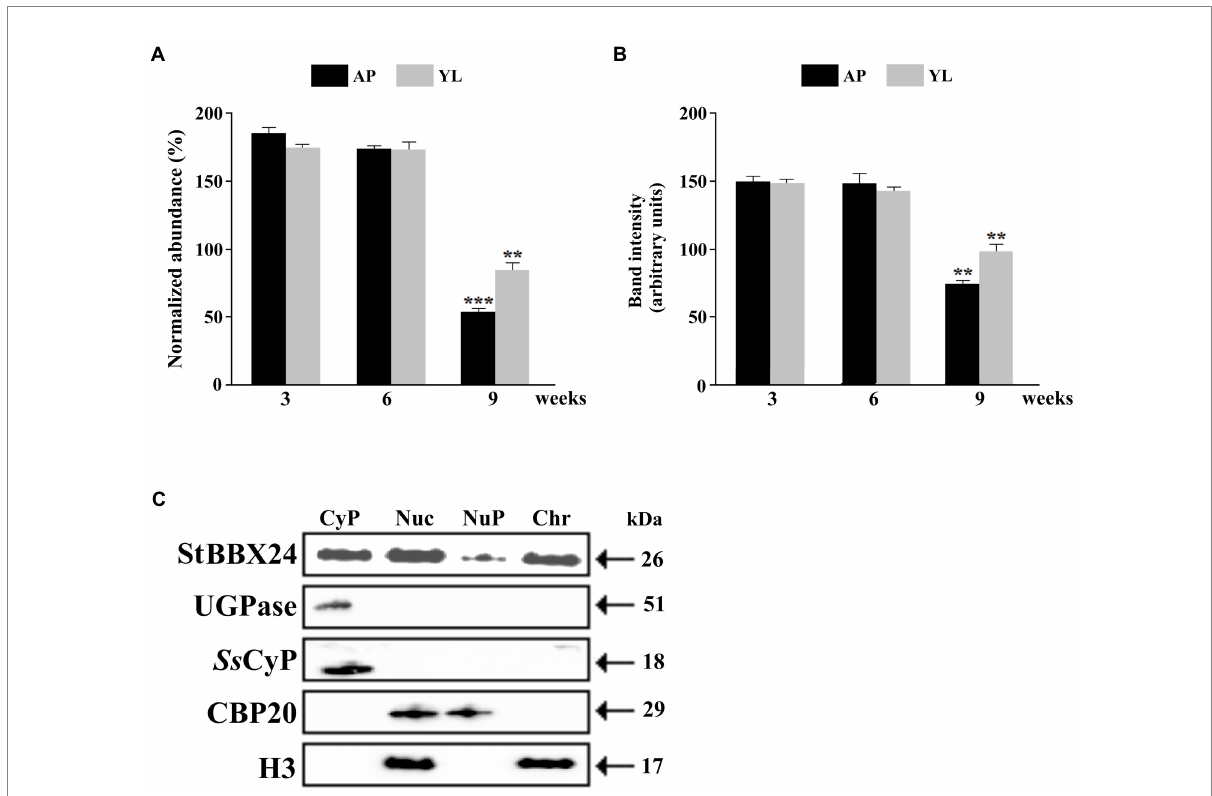
FIGURE 1 Expression of StBBX24 in young organs of S. tuberosum plants and nuclear localization of StBBX24. StBBX24 transcript (A) and protein (B) abundance in apical shoot parts and young leaves of phytotron-grown S. tuberosum plants. (A) Quantitative RT-PCR was performed as described in Materials and methods. (B) Western analysis of StBBX24 abundance was performed using sera raised against StBBX24 as described in Materials and methods. As a loading control of the total protein for cytosolic fraction, antibodies raised against cytosolic marker UGPase protein were used. AP – apical shoot part; YL – young leaves (including very young developing leaves). (C) Western blot analysis of proteins from cytosolic (Cyt), total nuclei (Nuc), nucleoplasm (NuP) and chromatin (Chr) fractions prepared from leaves of S. tuberosum plants. 10–40 μ g proteins from nuclei-enriched and cytosolic fractions were set per lane. The analysis was carried out using sera raised against StBBX24, UDP- glucosepyrophosphorylase (UGPase), cytosolic cyclophilin (CyP), histone H3 and cap-binding protein subunit 2 (CBP20). Means ± SD of four values from two independent experiments (two replicates per experiment) are presented. Statistical analysis was performed using the t- test (Statistica program, version 10). ** and ***, values significantly different from the 3-week old plants value with p < 0.01 and p < 0.001,